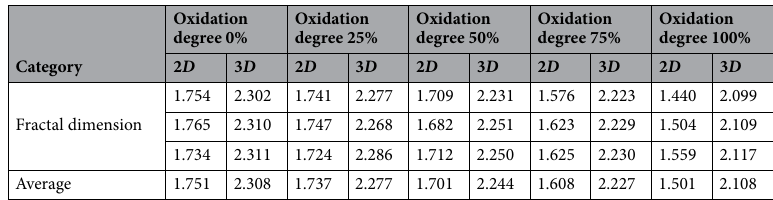
Table 5. Calculation results of 2 D and 3 D fractal dimensions of micro-surface.